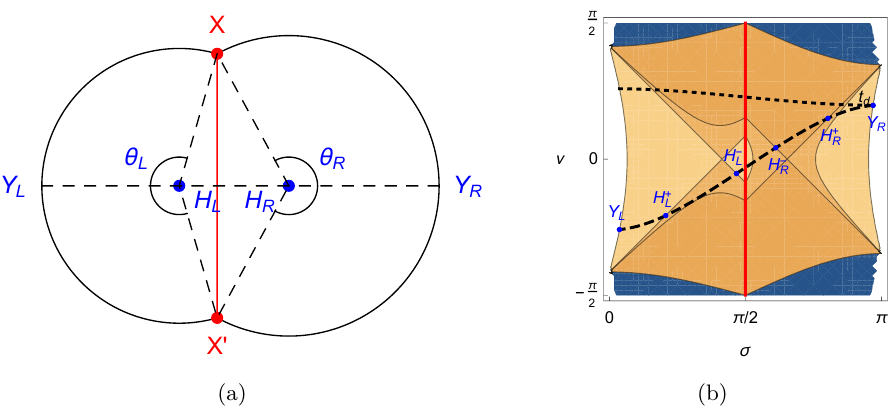
Figure 4 . (a) A schematic trajectory of boundary particles in hyperbolic space. The two segments and the vertical line represent the world lines of the two boundary particles and the inserted particle. The true horizon is point H R . (b) The configuration of the dilaton field in the global coordinate of AdS 2 with the operator insertions. The parameters are Q = 100 , L = 30 , µ = 20 and θ = π/ 20 . We plot the geodesics of C V ( − t d , t d ) (dashed) and C V ( t d , t d ) (dotted). These geodesics intersect the left boundary, left-outer horizon, left-inner horizon, right-inner horizon, right-outer horizon, and (cid:8) (cid:9) right boundary at points Y L , H + , H − , H − , H + , Y R L L R R